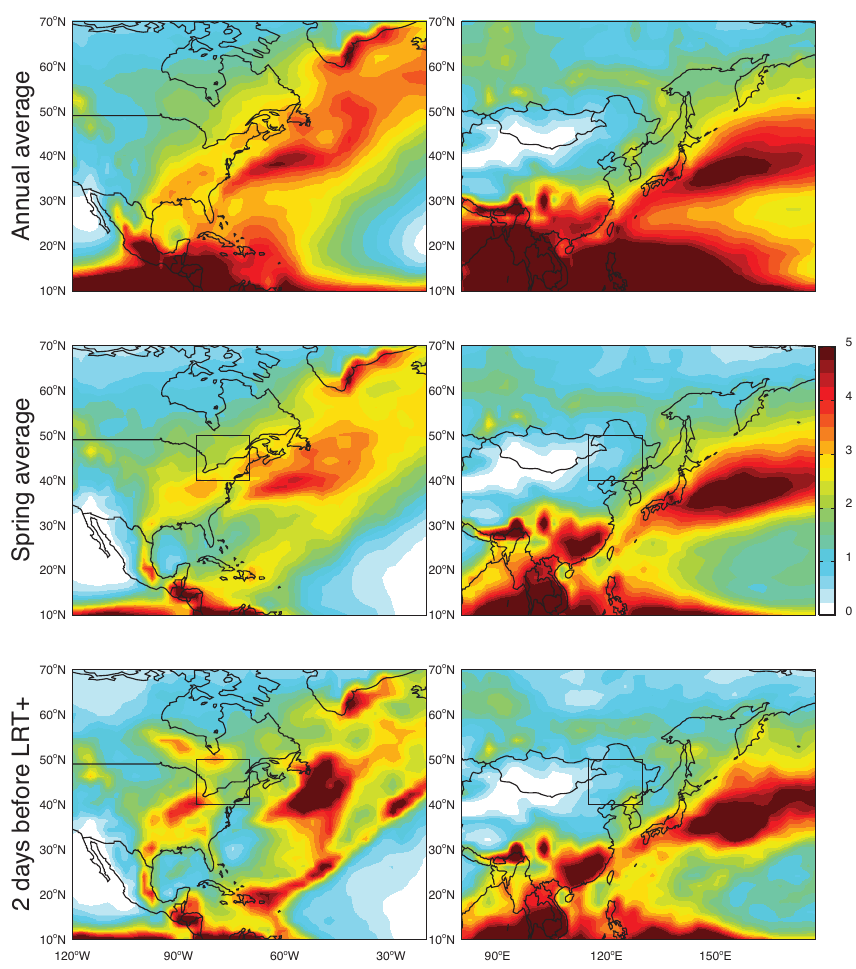
Fig. 12. Comparison of GEOS-5 precipitation in N. America (left) and E. Asia (right) (unit:mmday − 1 ). Top: Annual mean for 2004–2010. Middle panel: Spring mean for 2004–2010. Bottom panel: composite of springtime LRT + days with a 2 day lag. The box in the middle and bottom panels indicates the location of maximum AOD